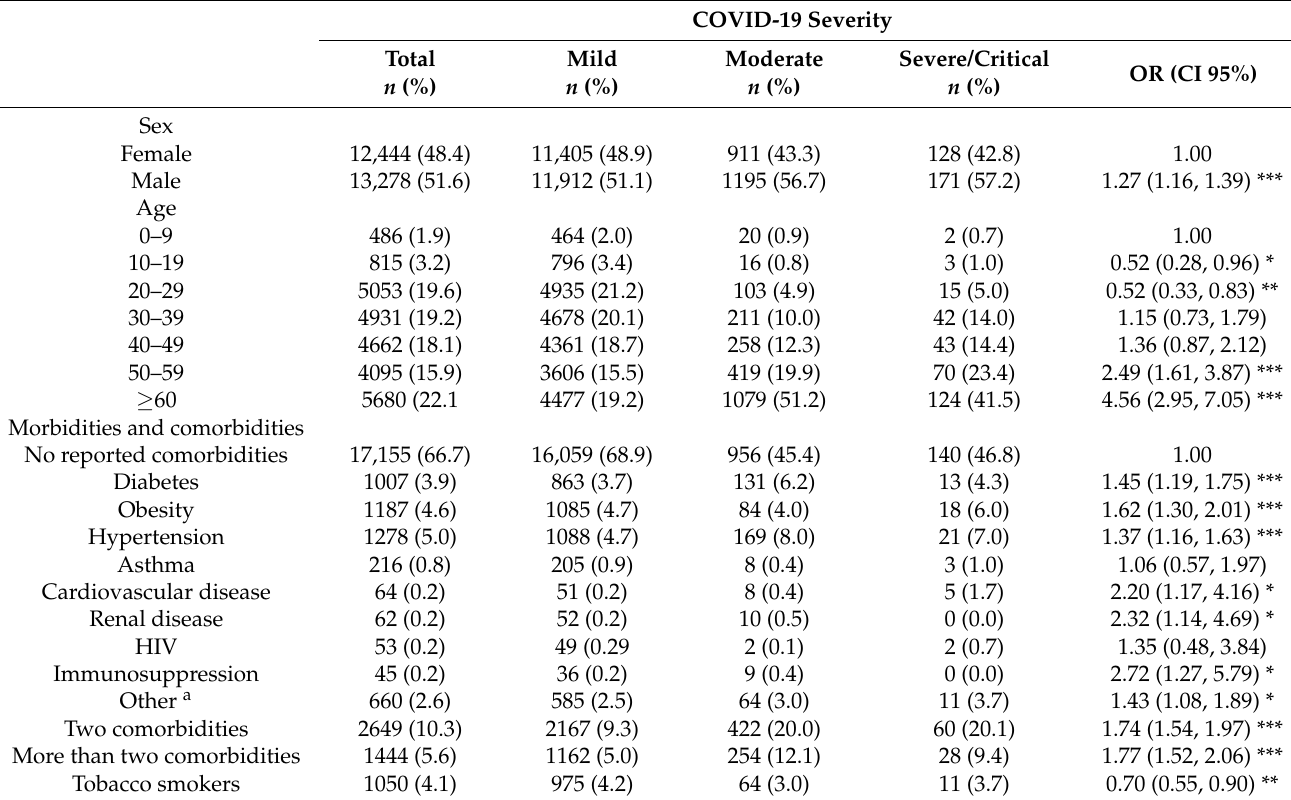
Table 3. Associated factors with critical COVID-19 ( n =